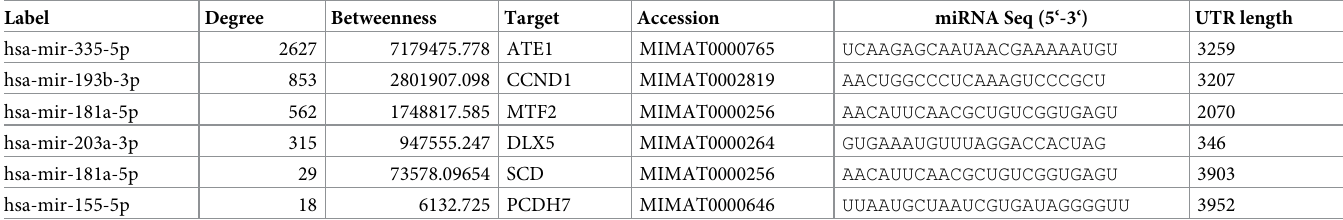
Table 2. The miRNA network centrality scores and its target gene